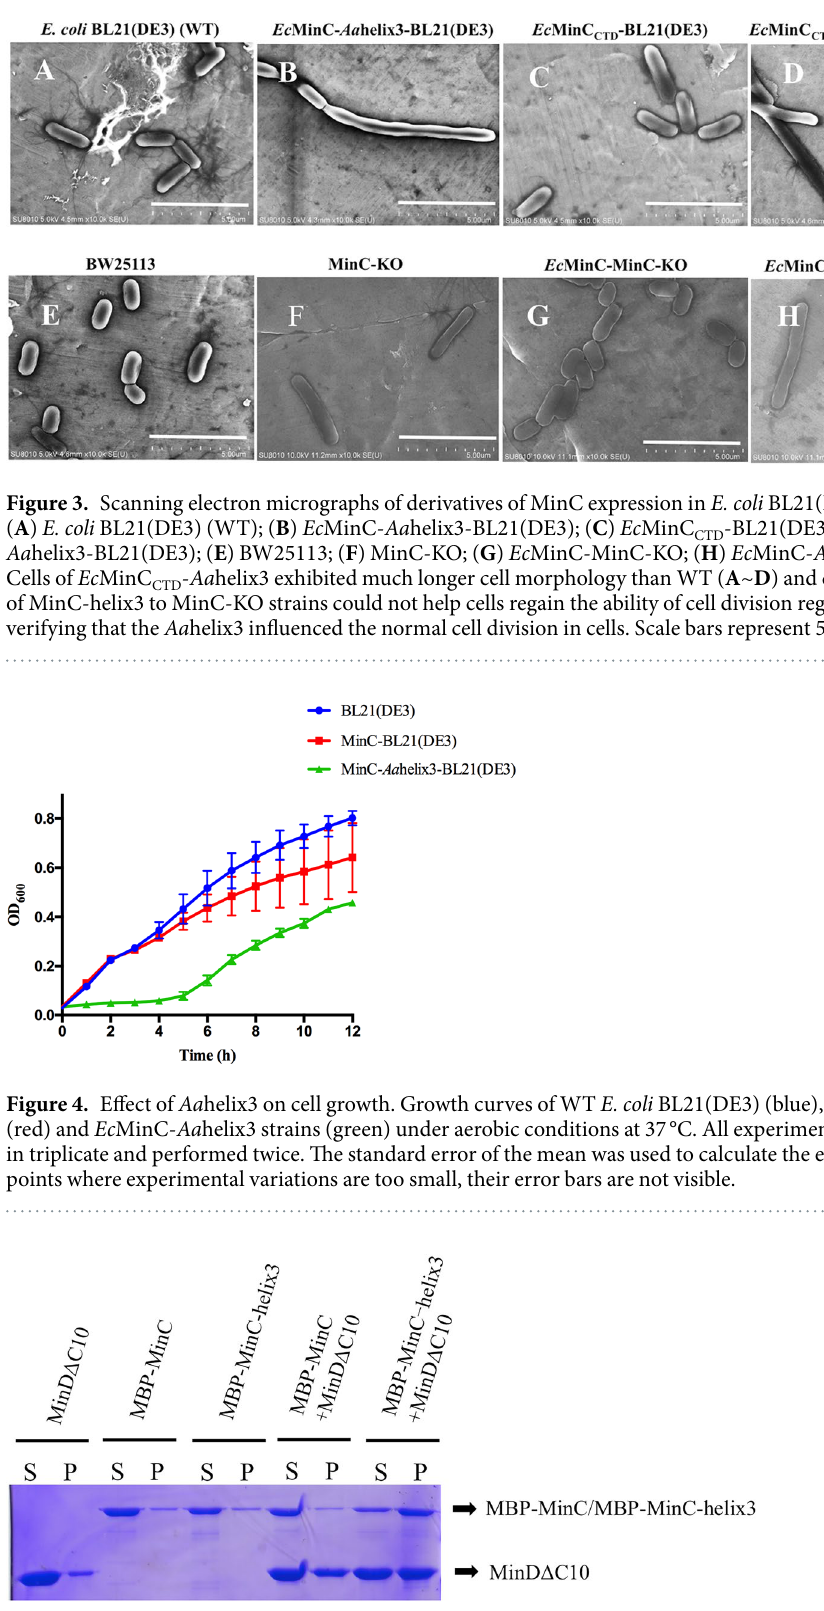
Figure 5. Formation of large complexes containing MinD and MinC. Mixtures containing combinations of Ec MinD Δ C10 (12 μ M) and MBP- Ec MinC (6 μ M) or MBP- Ec MinC- Aa helix3 (6 μ M), where incubated at 25 °C for 15 min and then fractionated by centrifugation. Supernatants and pellets were analyzed by SDS–PAGE and Coomassie Blue staining. This figure is a cropped gel and the full-length gel is shown in Fig.